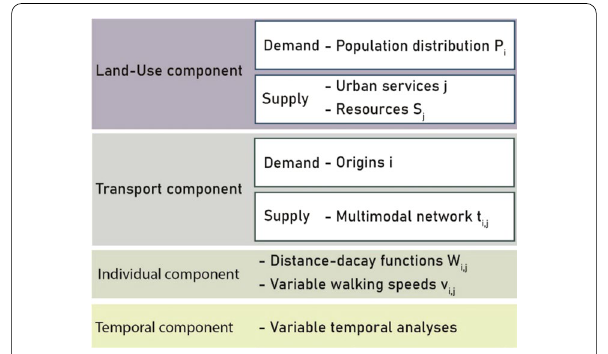
Fig. 2 EM2SFCA input (authors’